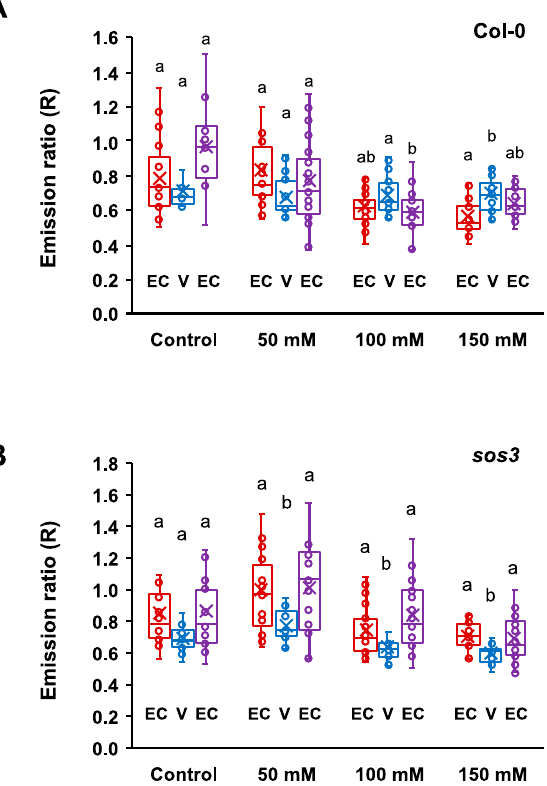
Figure 10. Cytosolic pH variation across the root sections of wild-type seedlings and the sos3 mutant. Box plots represent the mean fluorescence emission ratios (R) of pHGFP-LTI6b in different tissues for each condition and genotype. ( A ) Col-0, ( B ) sos3-1 . EC: epidermis and cortex; V: vasculature. Values were plotted from root segments S1 to S4 as defined in Supplementary Figure S3. Means are marked with symbol “x”. Outlier points are not shown but were included for statistical analyses. Different letters indicate groups with significantly different means for each genotype according to the Tukey HSD test at p <